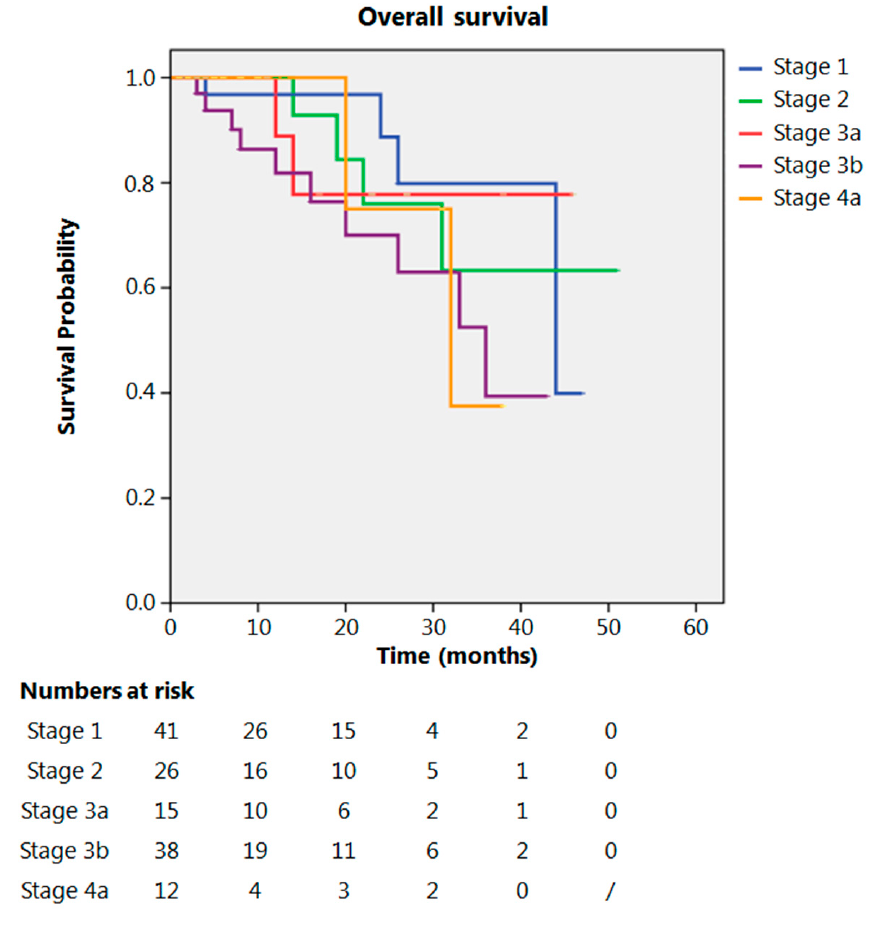
Figure 2. Overall survival according to yp stage .